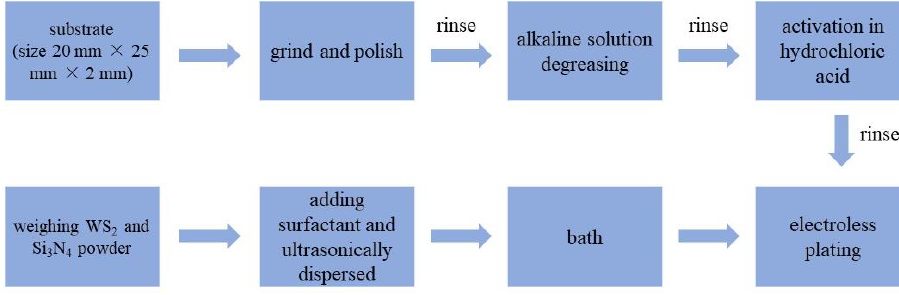
Figure 1. Preparation process of composite coatings.